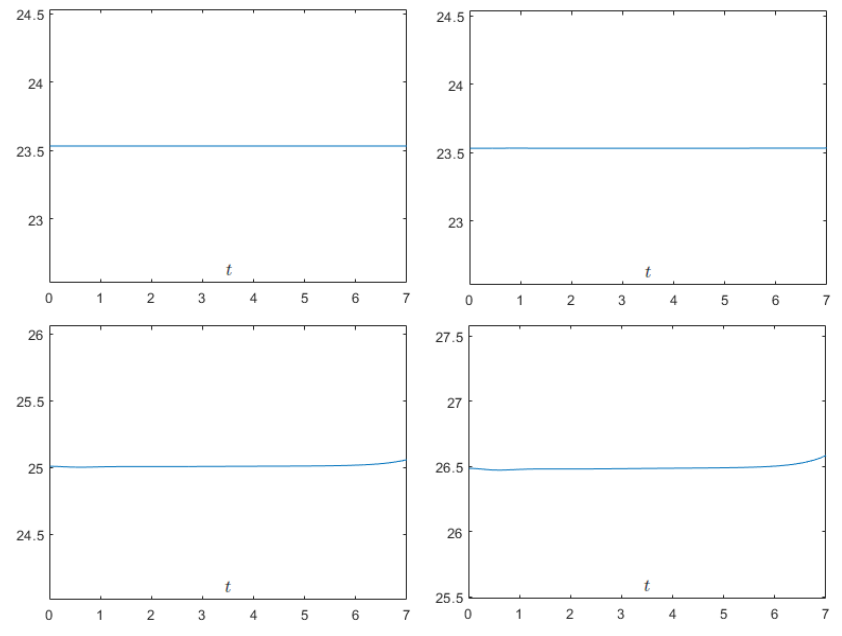
(cid:107) 2 computed by the numerical t